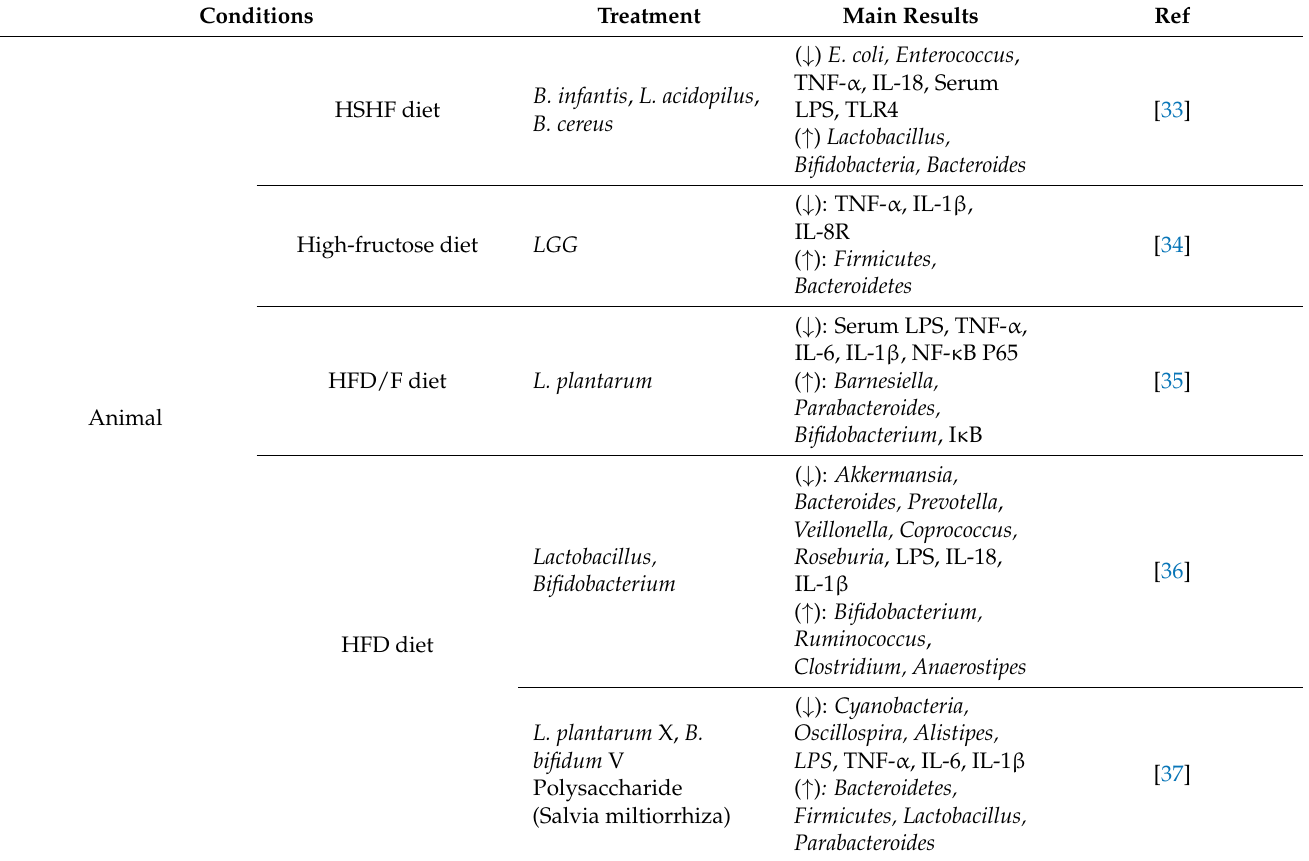
Table 1. Animal and human studies using diet in